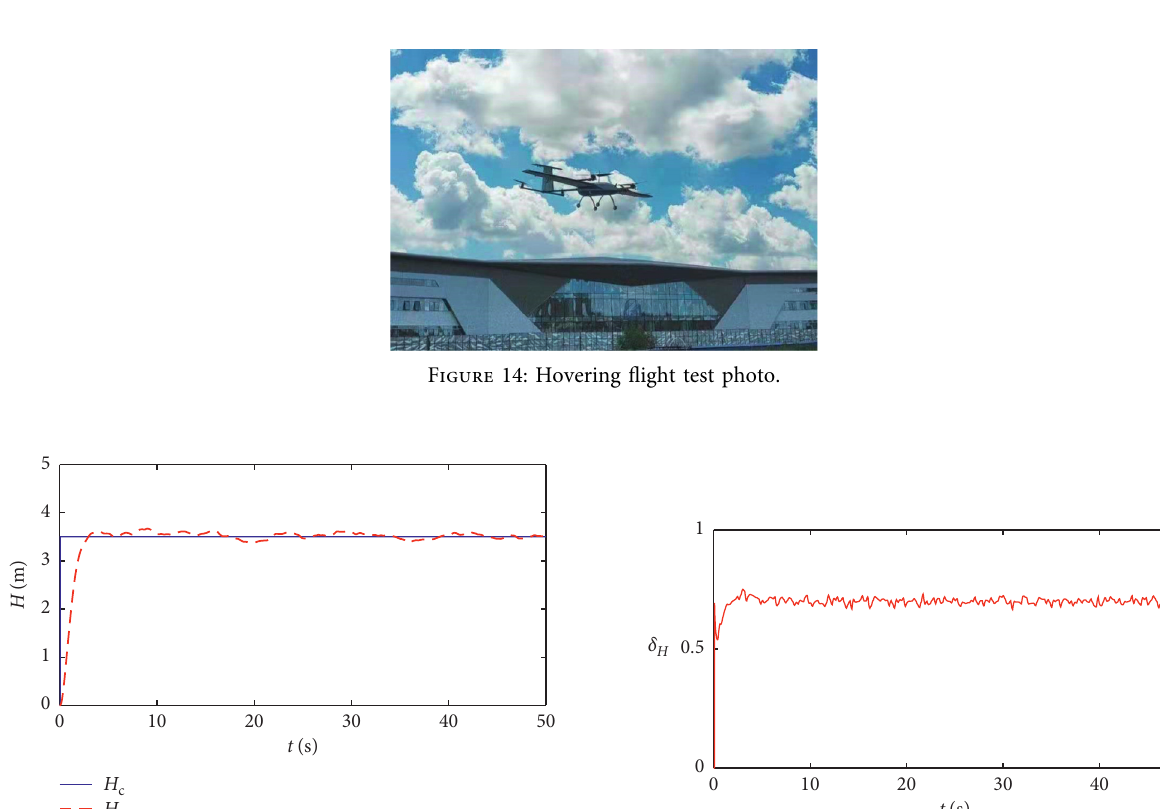
Figure 13: Block diagram of the platform.